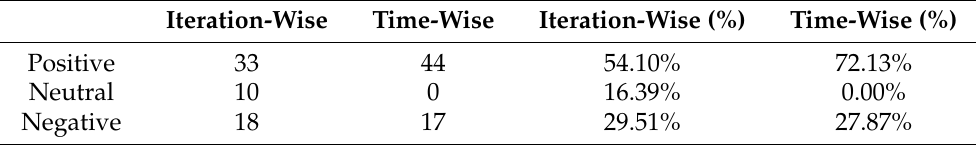
Table 3. Benchmark of AMPL presolve impact on solving. Sample models were solved with a Gurobi solver, and the solver’s presolve function turned off while keeping AMPL presolver on.